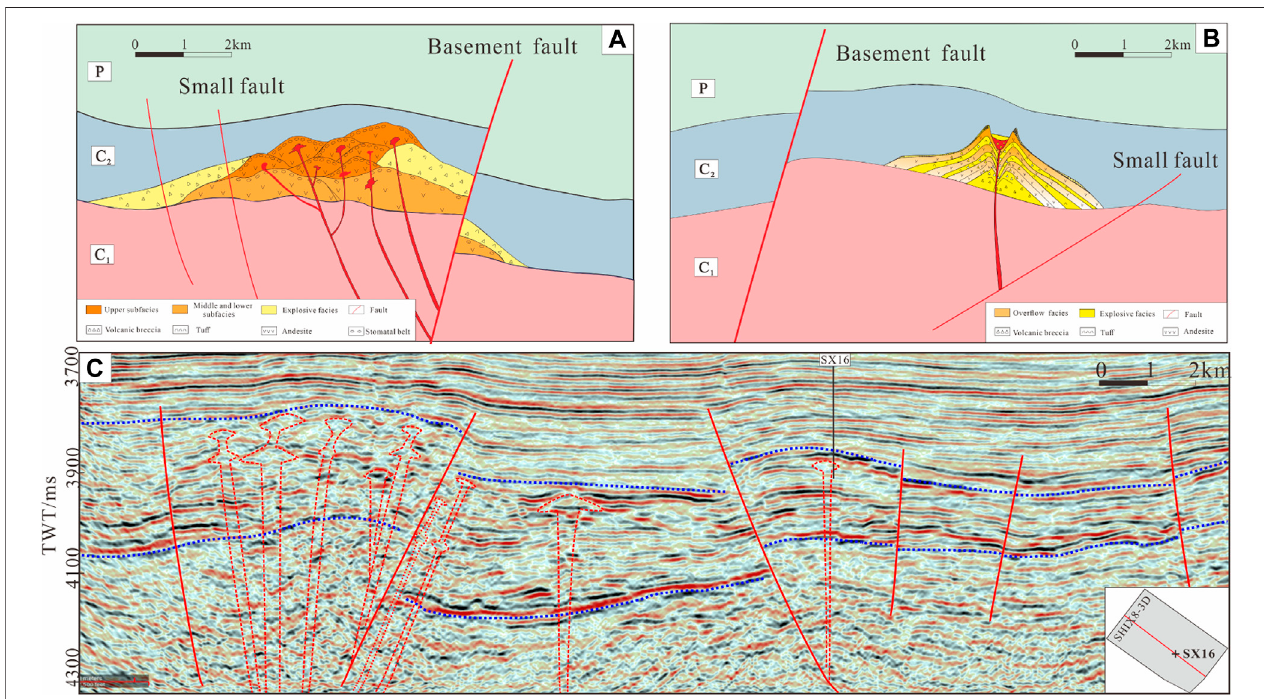
FIGURE6| Relationshipbetweenfaultsand volcanic edi fi cesintheShixiarea. (A) Whenfaults develop, moundsuperimposedvolcanicedi fi ces aredeveloped; (B) when faults are not developed, single stratovolcanic edi fi ces are developed; (C) seismic pro fi le through well SX16.